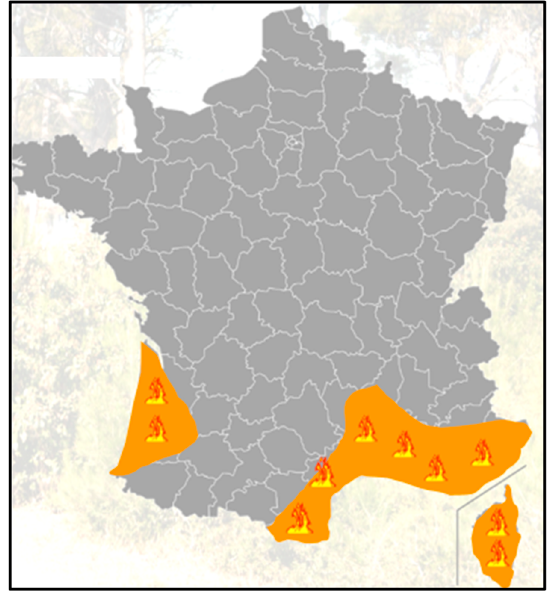
Figure 4. Provence Alpes Cote d’Azur (PACA) region and fire prone areas.